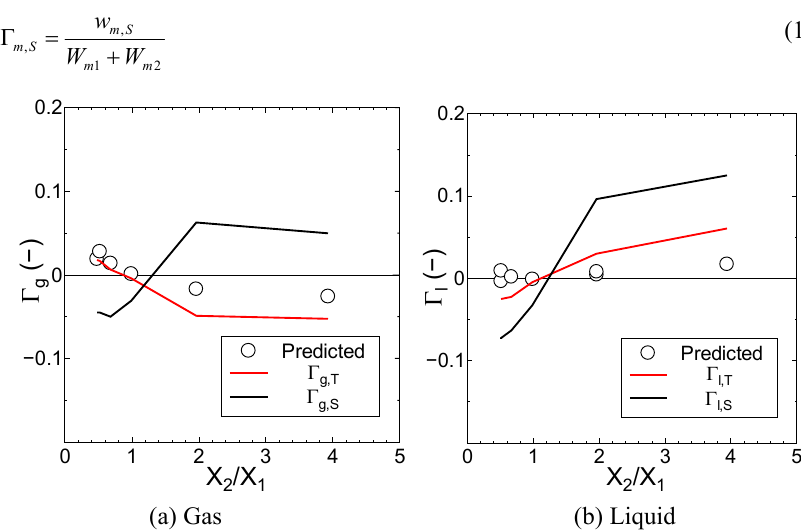
Fig.9 Evaluation of the fluctuating pressure model for BWR cases (Case